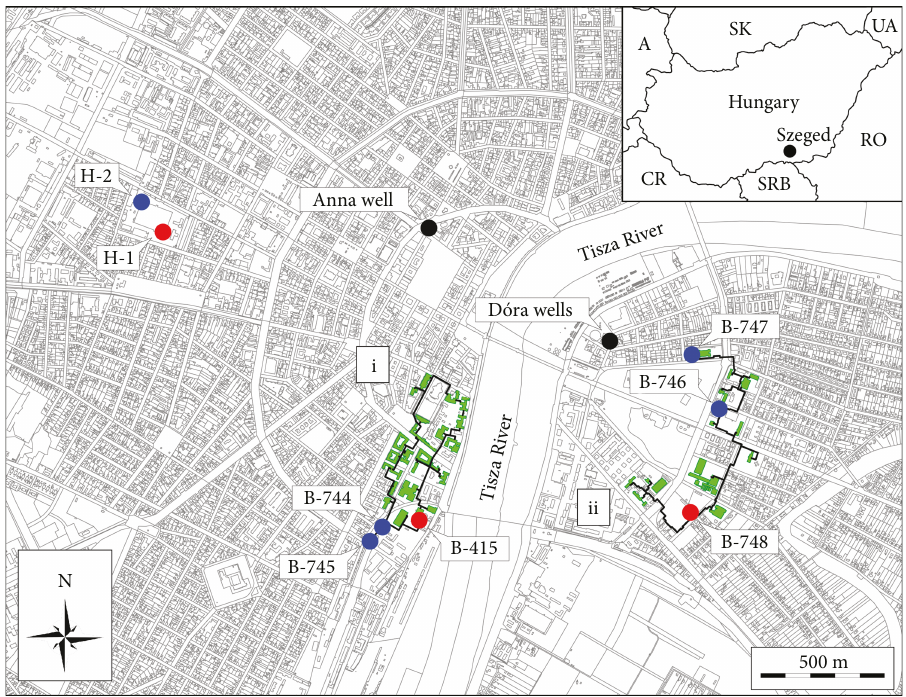
Figure 1: Geothermal cascade systems in Szeged (SE Hungary, Central Europe) together with locations of thermal production and reinjection wells (red and blue fi lled circles, respectively). (i) Geothermal cascade system in downtown of Szeged. (ii) Geothermal cascade system in Újszeged district. Mineralogical and petrographic rock characterization was carried out on core samples from the H – 1 exploration